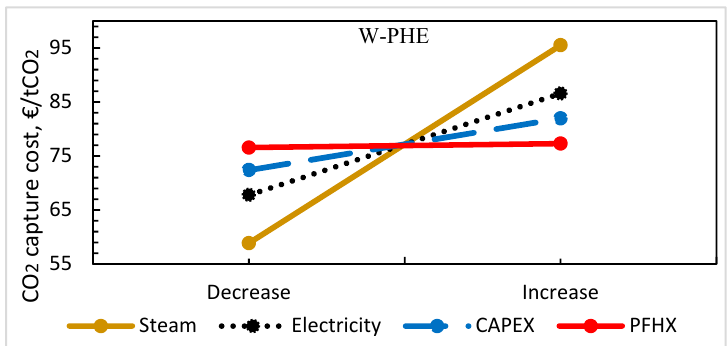
Figure 12. Sensitivity of important economic variables on the capture cost of the FDP-HX case.